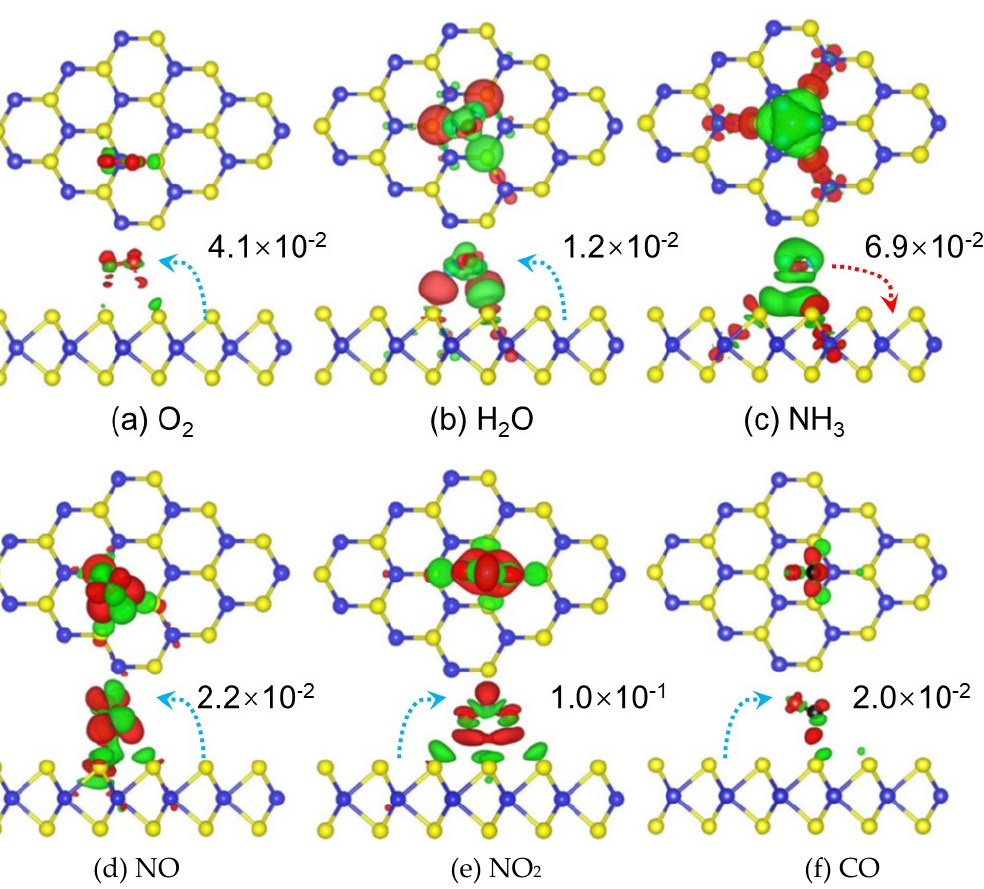
Figure 2. Charge density difference plots for ( a ) O 2 , ( b ) H 2 O, ( c ) NH 3 , ( d ) NO, ( e ) NO 2 , and ( f ) CO interacting with monolayer MoS 2 . Reprinted with permission from Ref. [39]. Copyright 2013 Springer.